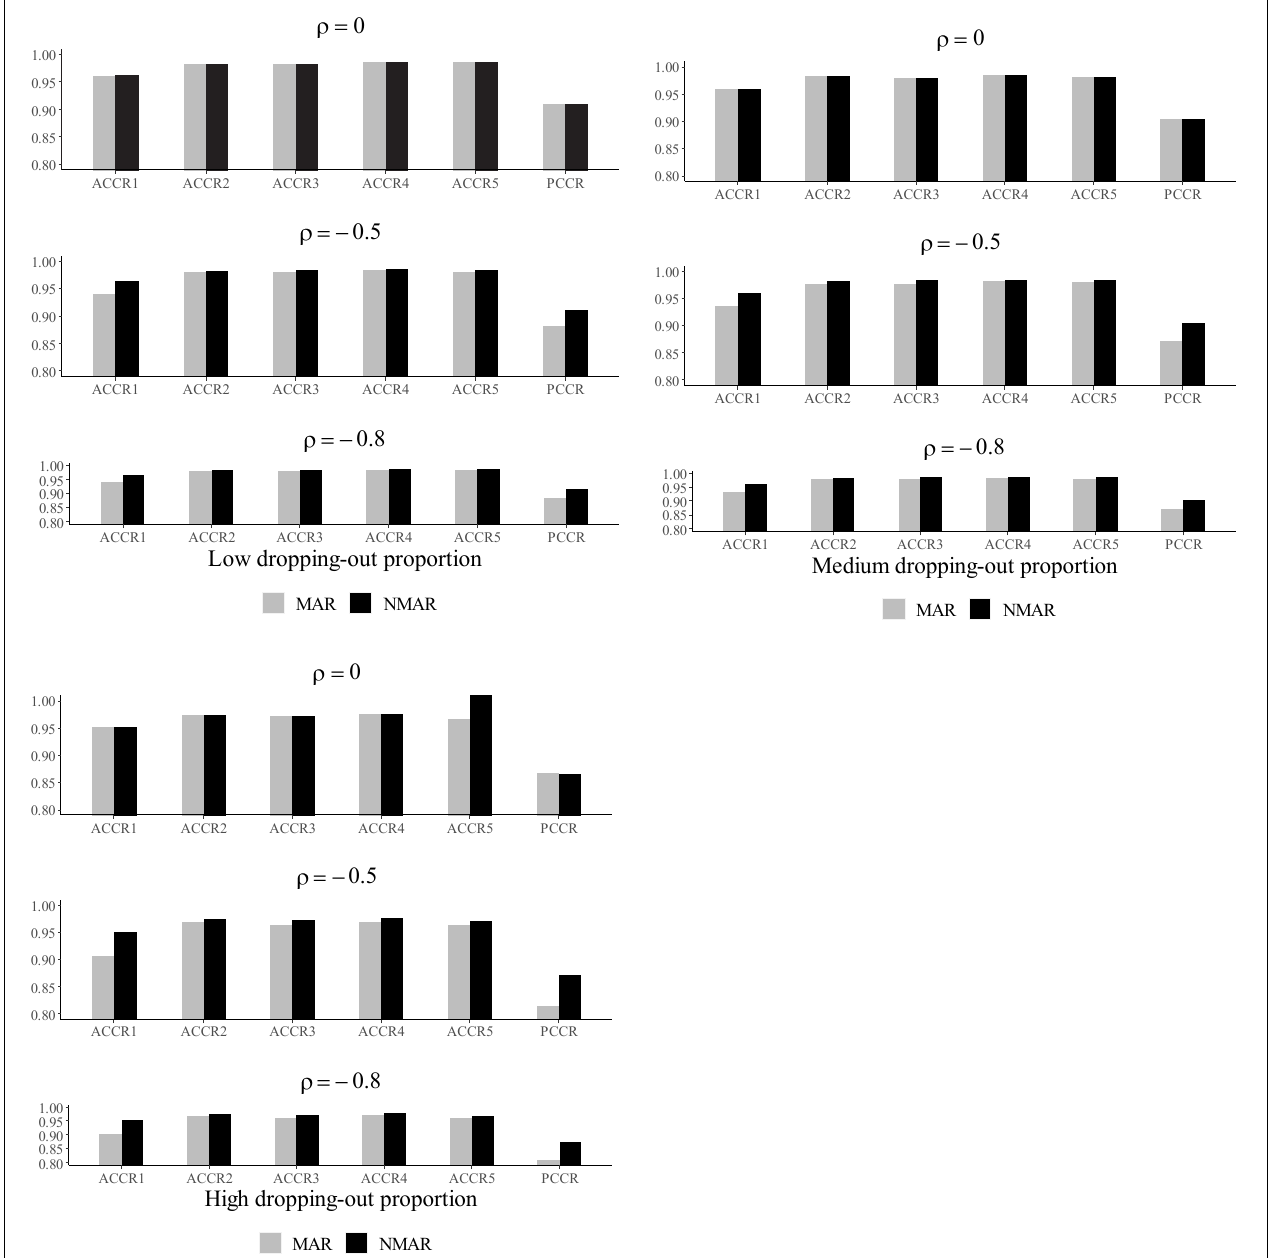
FIGURE 5 | The ACCRs and PCCRs of NMAR and MAR models under different correlations between θ h i and θ d i and different dropping-out proportions in simulation study